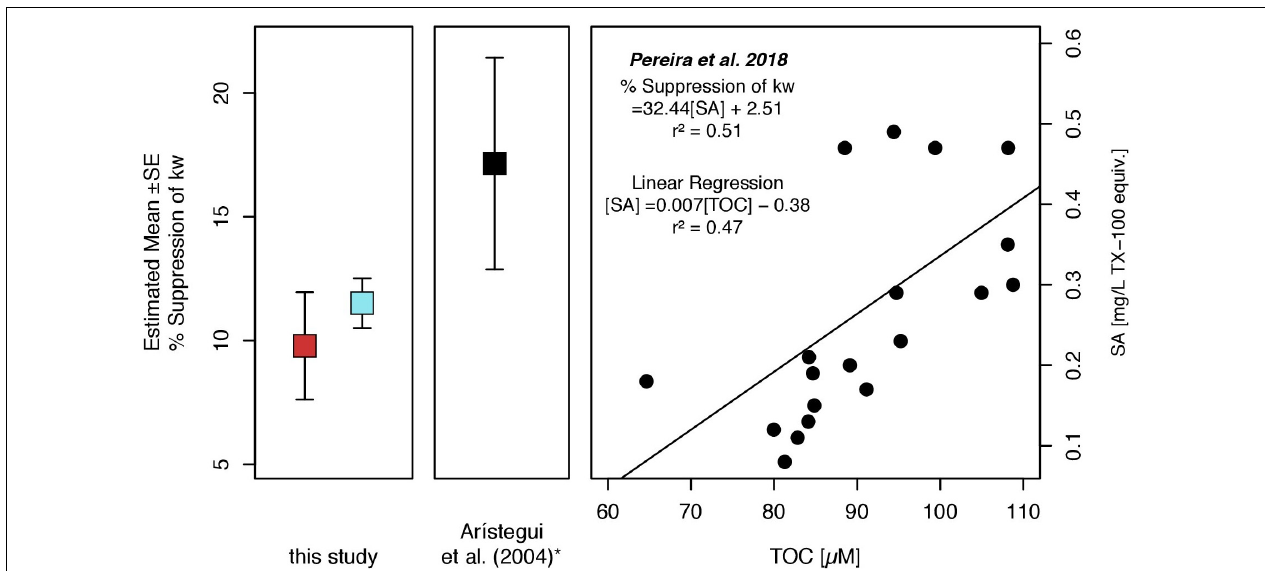
FIGURE 7 | Suppression of the CO 2 gas transfer coefficient ( k W ) as estimated for SML surfactant concentrations (SA). Suppression of k W was calculated by using the equation of Pereira et al. (2018). The linear regression model enables to predict the suppression of k W , if TOC surface measurements are available. (*) We included an estimation of k W suppression based on TOC concentrations measured in surface waters (5 m) along a zonal transect near Cape Juby (NW Africa) and within the trajectory of a permanent filament as an example (Arístegui et al., 2004). Squares indicate mean estimated suppression of k W for inside (blue) and outside (red) the filament and for the zonal transect (black). Whiskers represent the standard error of